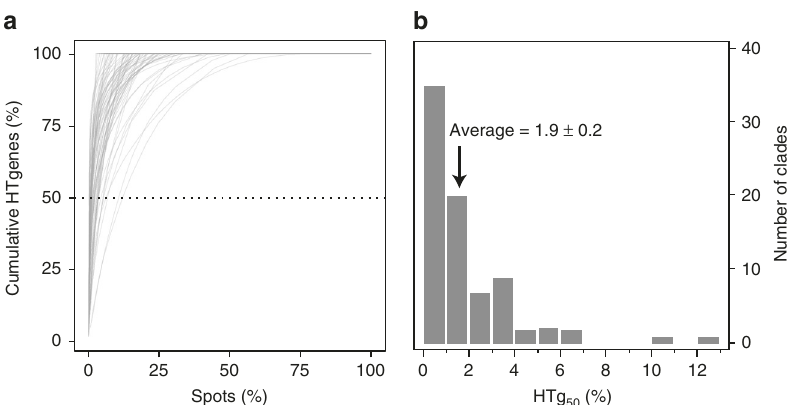
Table 1 Acronyms used in this study MGE Mobile genetic element (i.e., prophage, ICE, IME and integron) ICE Integrative conjugative element IME Integrative mobilizable element MAP Mobility-associated protein (i.e., integrase and transposase (IS)) ARG Antibiotic resistance gene HGT Horizontal gene transfer HTgenes Genes having been horizontally transferred Number of spots required to include 50% of HTgenes T Minimal number of HTgenes required to de fi ne a hotspot